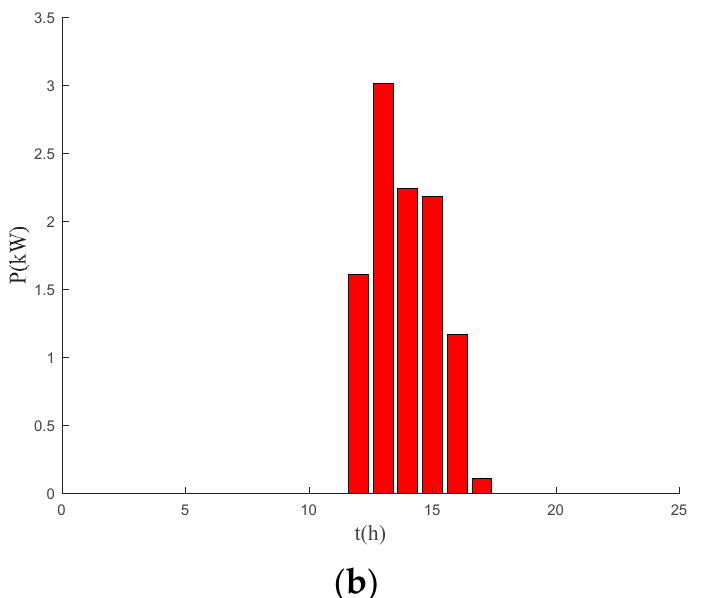
Figure 11. Scheduling results of microgrid based on the DDPG algorithm. ( a ) Scheduling results of microgrid. ( b ) Curtailment of PV generation and load.